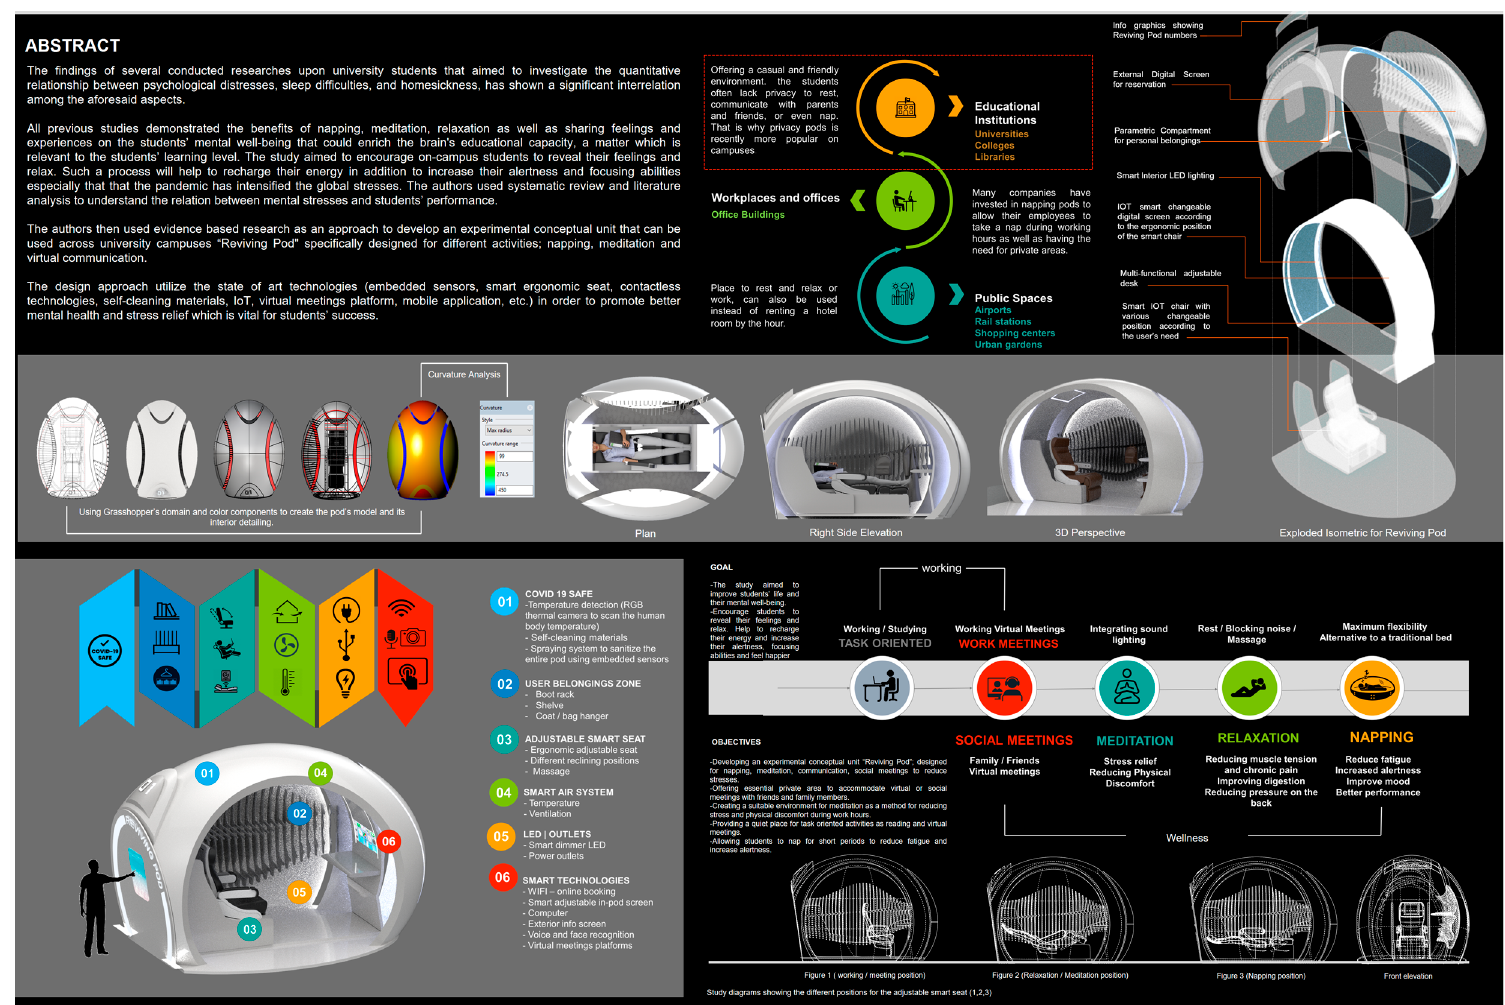
Figure A1. Samples of the posters (Poster1) displayed on 6 February 2022 on DAU campus in the CADD Female Exhibition.